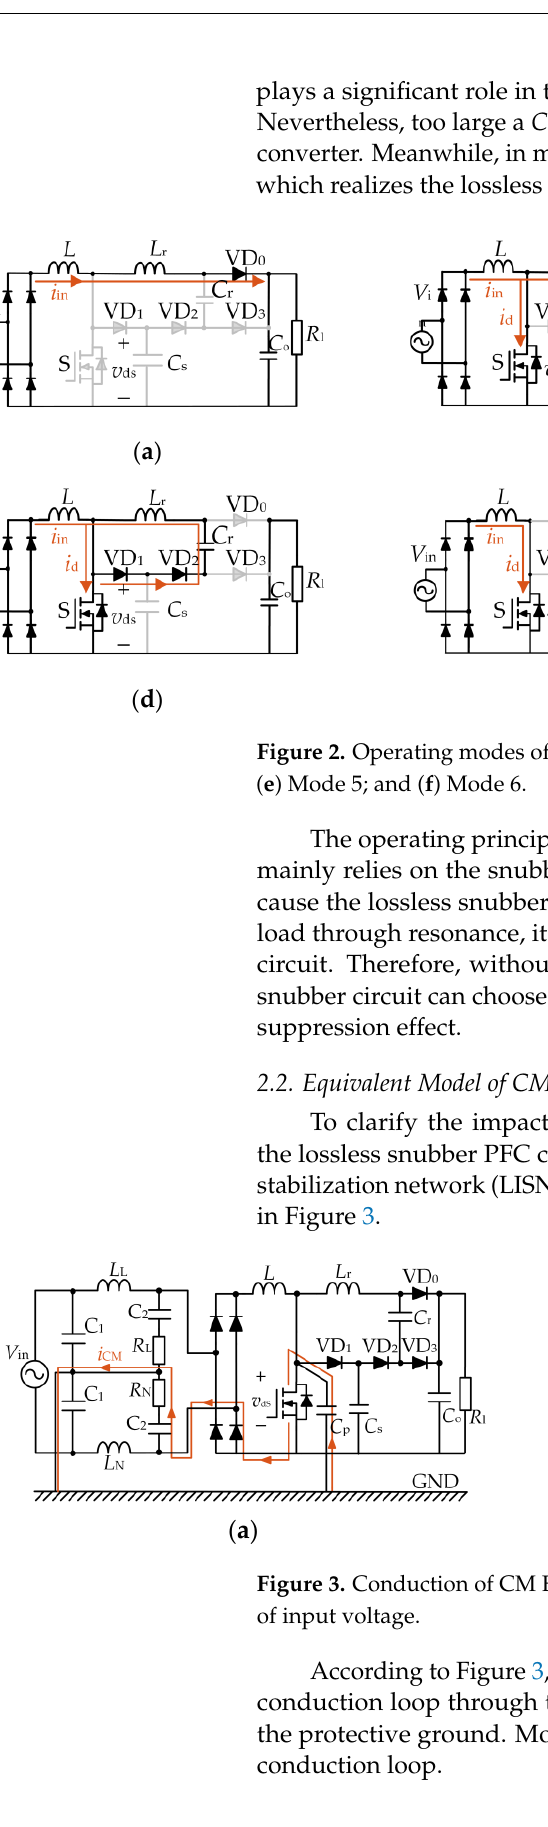
Figure 4. Equivalent circuit of CM EMI. 2.3. CM EMI Suppression Effect of Snubber Circuit As v ds is the primary source of CM noise, the analysis of the CM EMI suppression effect of the snubber circuit can be equated to the analysis of the effect of the snubber circuit on the v ds spectrum. The v ds waveform is usually approximated as a trapezoidal waveform to simplify the analysis. Decomposing v ds into Fourier steps, the amplitude of each harmonic can be obtained as: A ( k )=2 A t τ w f s | sinc( k π f s τ w ) || sinc( k π f s τ r ) | (2) In Equation (2), k = 1,2,3, ..., denotes the number of harmonics. The function A ( k ) represents the amplitude of the k th harmonic. The function sinc( x ) = sin x / x . A t is the am- plitude of the trapezoidal wave; f s is the switching frequency; τ w is the time between the voltage rising to A t /2 and falling to A t /2, and τ r is the rise and fall time of the voltage. Due to the fast switching speed of the power-switching devices, the drain – source voltage ’ s rise and fall times are short. So, there is τ w >> τ r . According to Equation (2), the envelope of the harmonic amplitude decays with a slope of −2 0 dB/dec when the number of harmonics is greater than 1/( π f s τ w ). When the number of harmonics is greater than 1/( π f s τ r ), the decay slope is −4 0 dB/dec. Increasing the snubber capacitance suppresses d u /d t and reduces the rate of rise of v ds . When the higher harmonics start to decay at a relatively low number of times with a slope of −4 0 dB/dec, this reduces the CM noise at high frequencies. However, to ensure the converter ’ s regular operation, the value of the snubber capacitor should not be too large, resulting in a lossless snubber circuit for the relatively low-frequency band of the CM noise suppression effect that is poor.